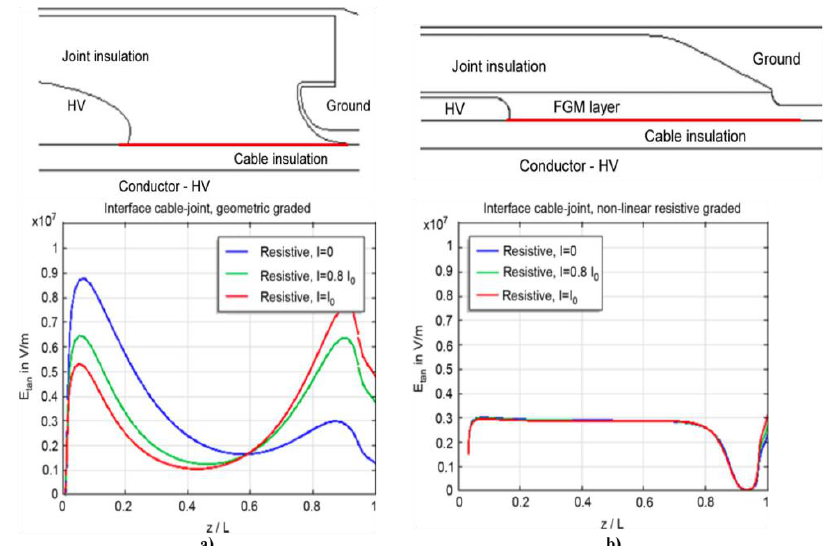
Figure 50. Cable accessories with field-grading materials: ( a ) typical prefabricated joint design and ( b ) HVDC cable termination. © 2021 IEEE. Reprinted, with permission, from [37]. Ghorbani et al. reported the difference between the tangential electric field along the cable – joint interface for a joint with geometric and nonlinear resistive grading (see Figure 51) [37].